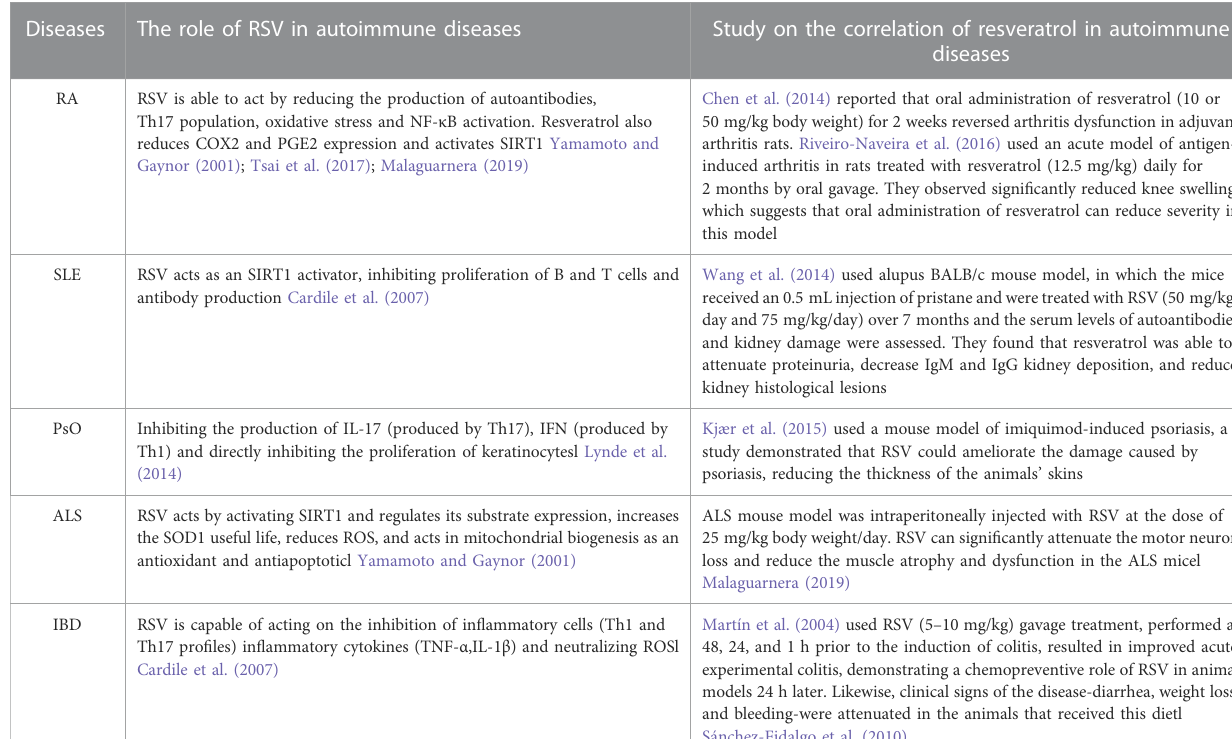
TABLE 3 Study on RSV in autoimmune